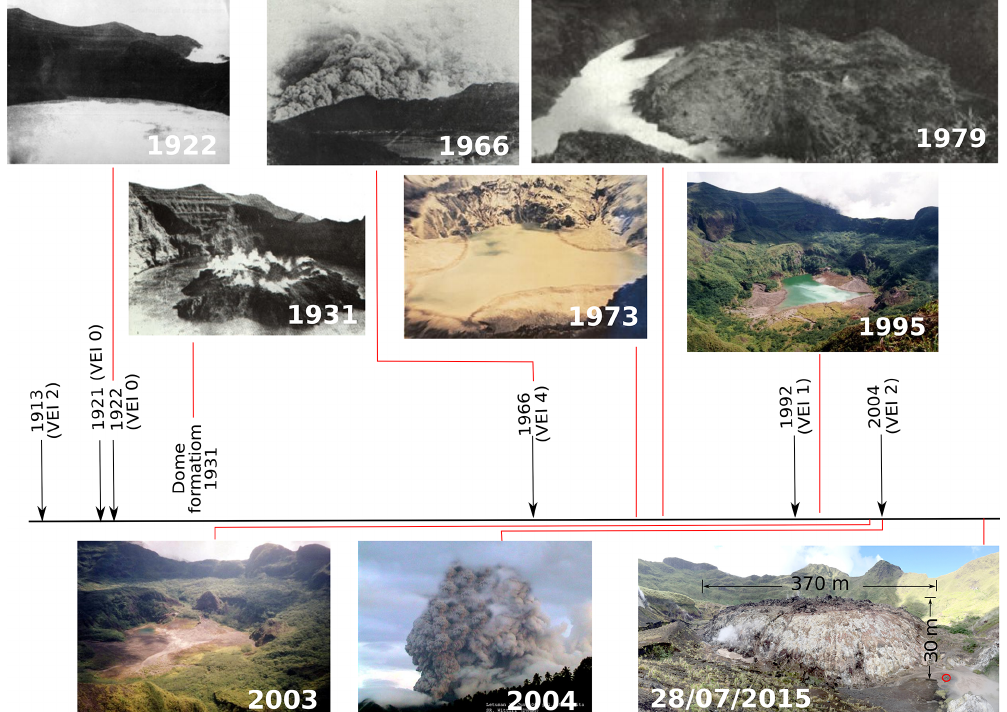
Figure 6. The configuration in Awu’s crater is subjected to evolve from crater lake to lava dome emplacement and also from unoccupied crater to coexistence of lava dome and crater lake. Pictures from GVP (2013a, b) (Awu) except 2015 (this